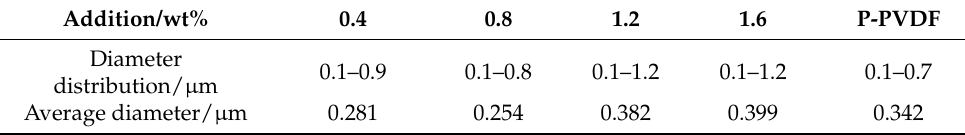
Figure 13. The fiber diameter distribution at different addition of FeCl 3 · 6H 2 O: ( a ) the addition of 0.4 wt%; ( b ) the addition of 0.8 wt%; ( c ) the addition of 1.2 wt%; ( d ) the addition of 1.6 wt%. Table 6. The average diameter of the fiber membrane at different loading of FeCl 3 ·6H 2 O.